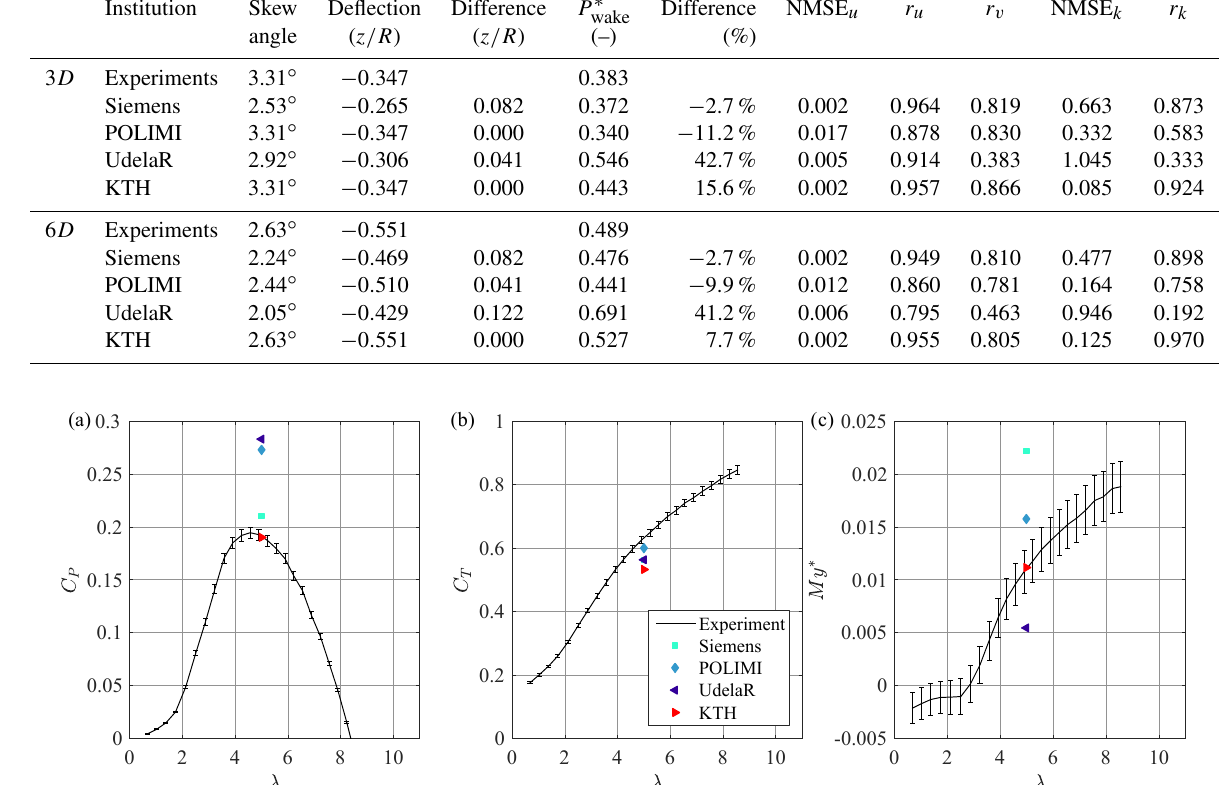
(c) for the T2 downstream y, LARS1